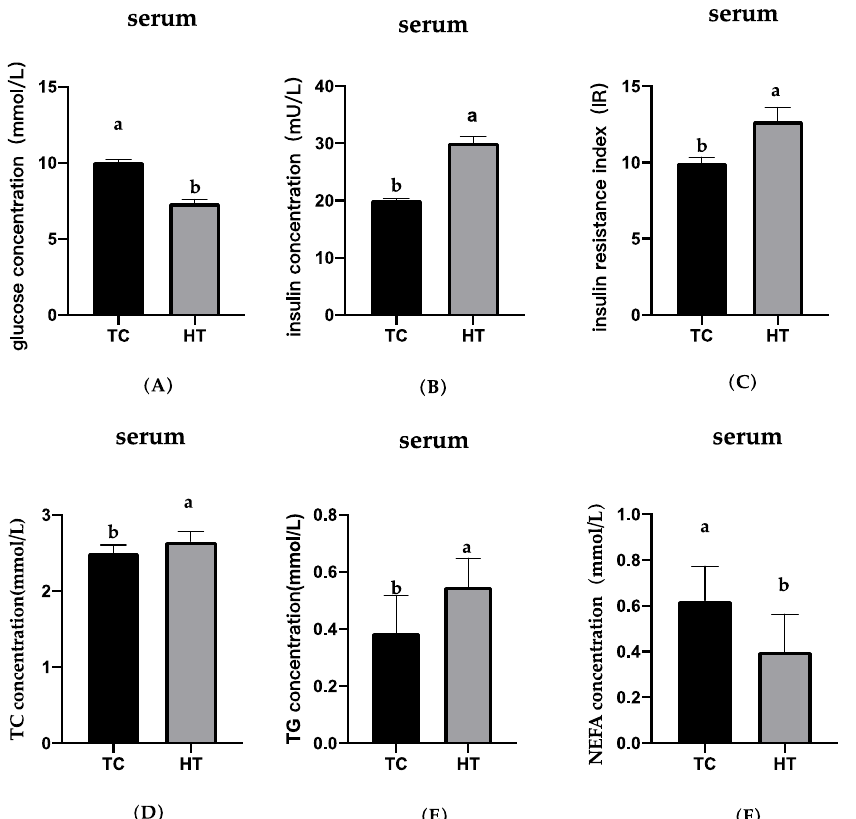
Figure 4. Effect of high temperature on blood glucose, insulin, insulin resistance index, TC, TG, and NEFA in serum. ( A ), blood glucose; ( B ), insulin; ( C ), insulin resistance index; ( D ), total cholesterol; ( E ), triglyceride; ( F ), non-esterified fatty acid. a,b means with different letters within columns indicates significant differences ( p < 0.05).